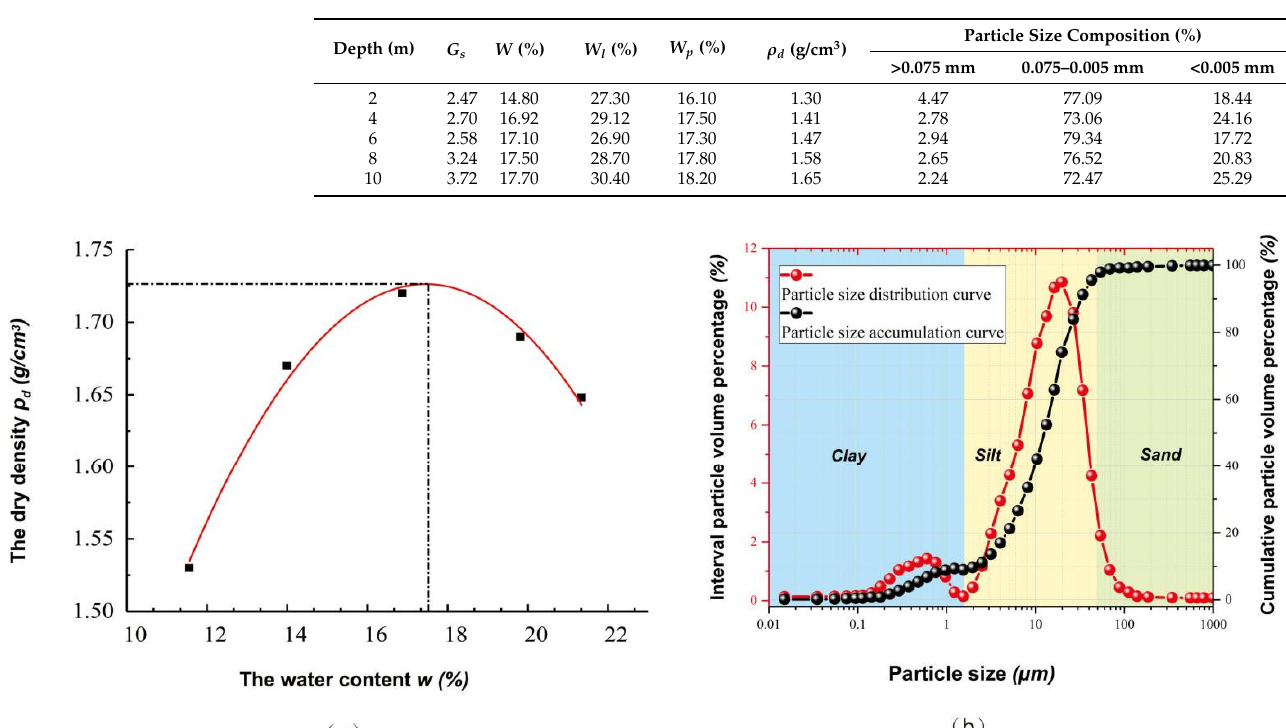
Figure 2. ( a ) The compaction curve of Malan loess in the Chanhe section. ( b ) The particle size dis- tribution curve and particle size grading accumulation curve.